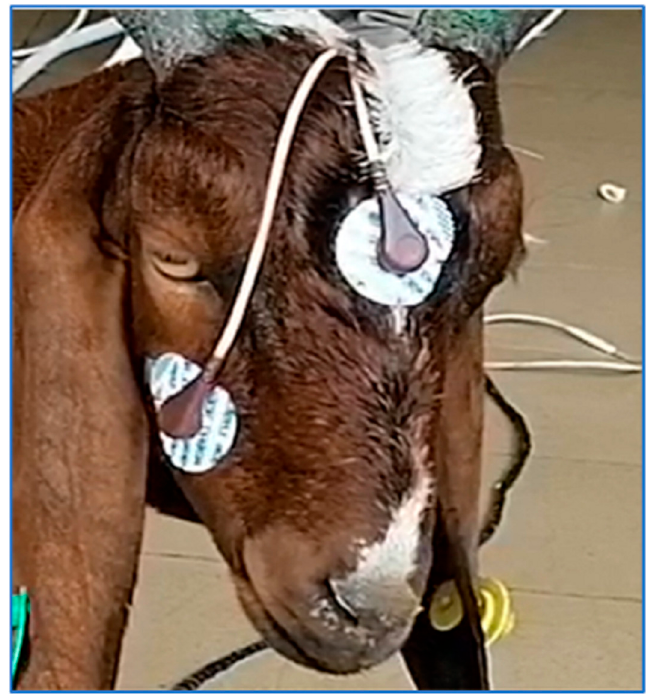
Figure 2. Placement of the EEG electrodes.